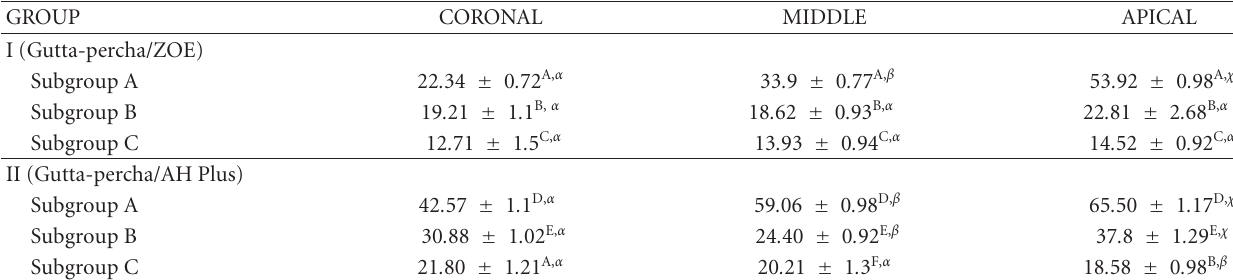
Table 1: Percentage (Mean ± S.D) of remaining root filling material in each group at di ff erent